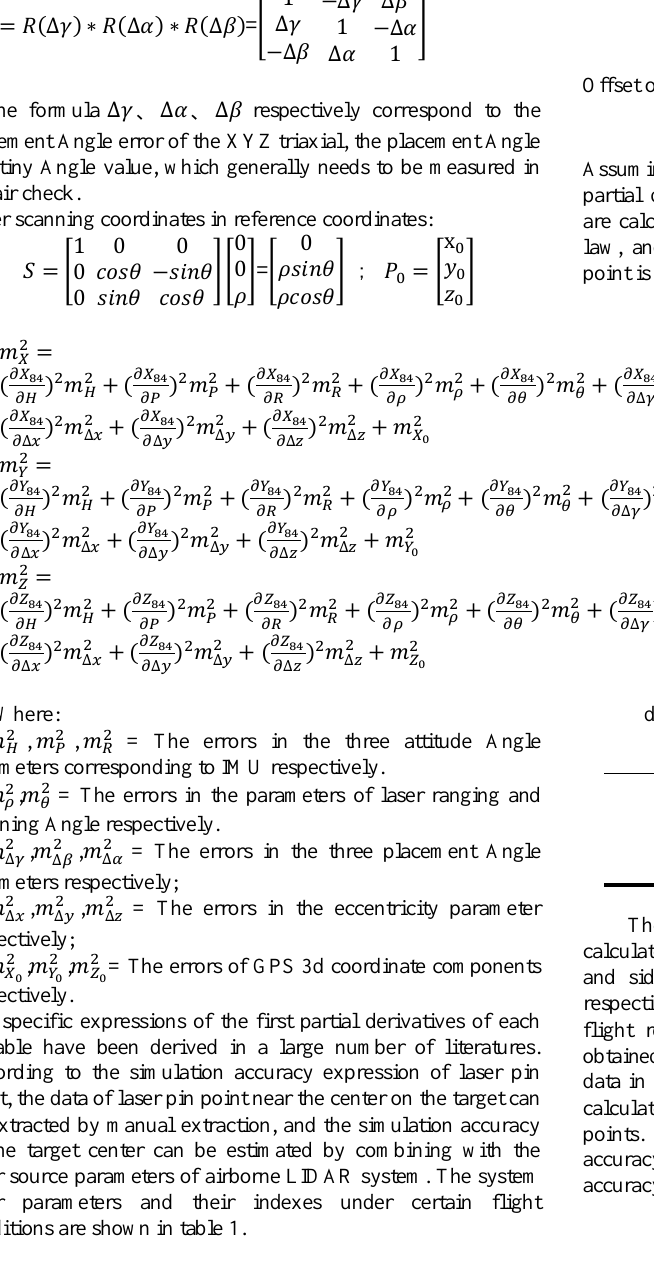
Table 1 Error sources and